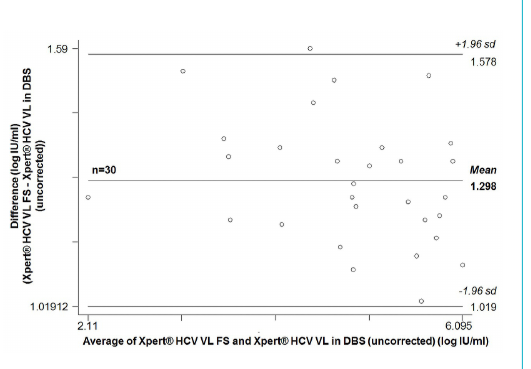
Figure S1: Bland-Altman plot of 30 paired quantifiable HCV RNA measurements: Xpert ® HCV Viral Load Fingerstick (VL FS) test versus Xpert ® HCV Viral Load (VL) test in dried blood spots pro- duced with 100 µl capillary whole blood (uncorrected results). sd = standard deviation; average bias: 1.298 (95% CI 1.246–1.350); 95% limits of agreement 1.019–1.578; Pitman’s test of difference in variance r = –0.283, p = 0.161